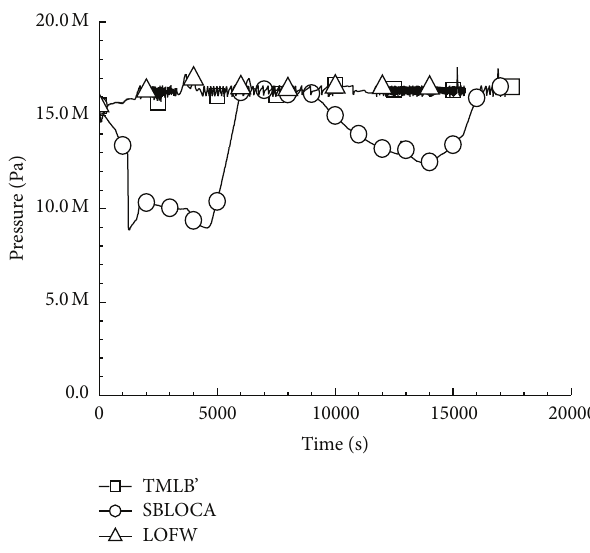
Figure 2: RCS pressure without activation of SADV.